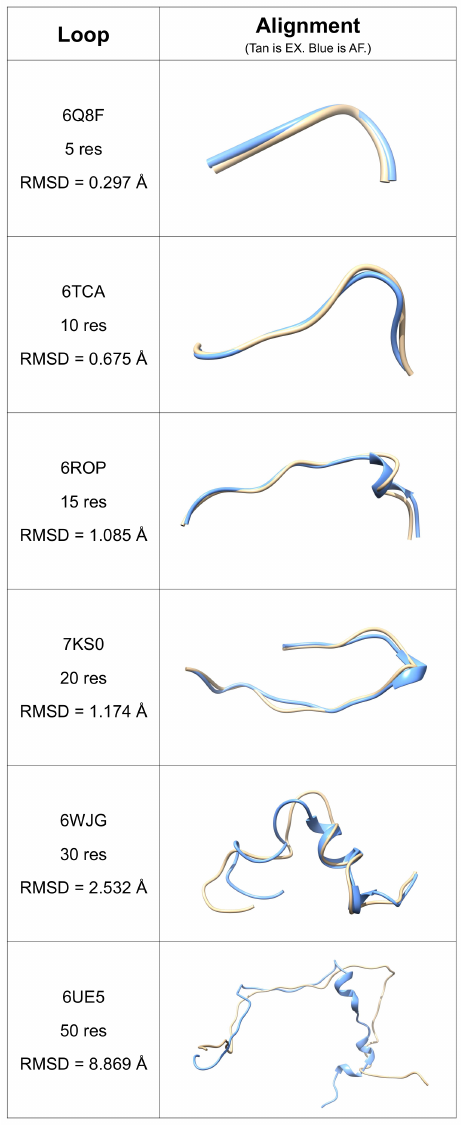
Figure 5. Representative examples of AlphaFold 2 predictions. The experimentally determined structures (EX) are shown in tan, and the AlphaFold 2 predicted structures (AF) are shown in blue. As the number of residues in the loop increases, the RMSD between the experimentally determined structures and the AlphaFold predicted structures also increases. Furthermore, as the number of residues in the loop increases, the secondary structure content in the AlphaFold 2 predicted structures also